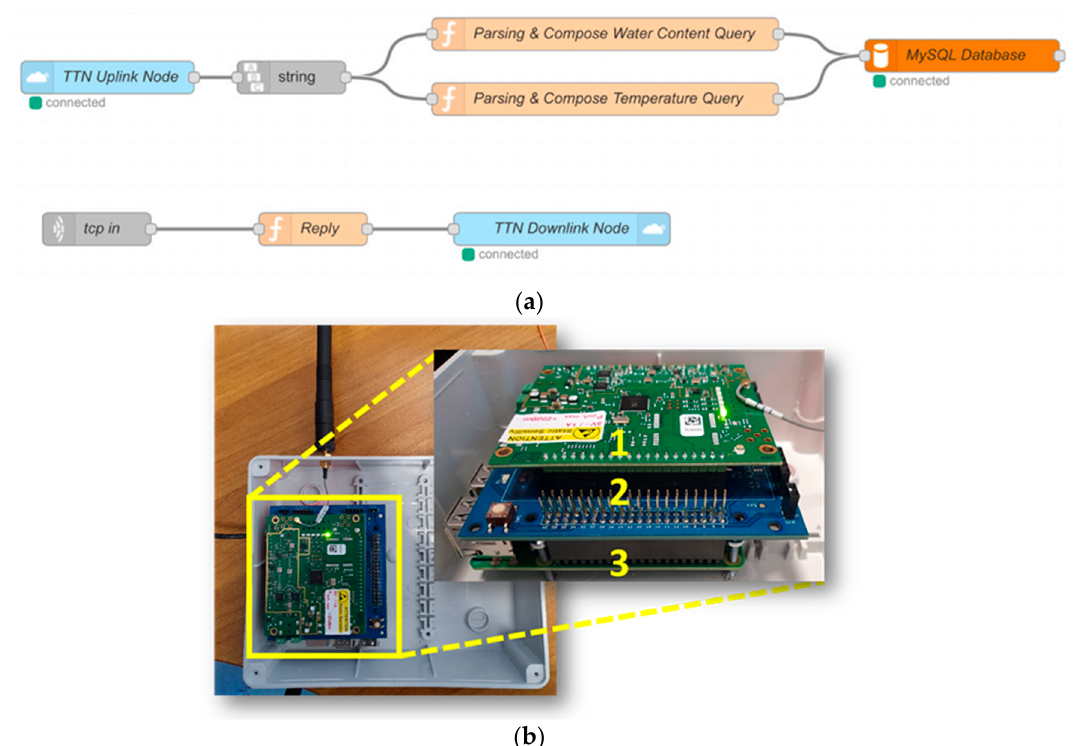
Figure 7. ( a ) The Node-RED flow running in the Raspberry of the Gateway. ( b ) The 8-channel iC880a /Concentrator, with interconnection backplane and Raspberry PI3, is mounted in a plastic box.